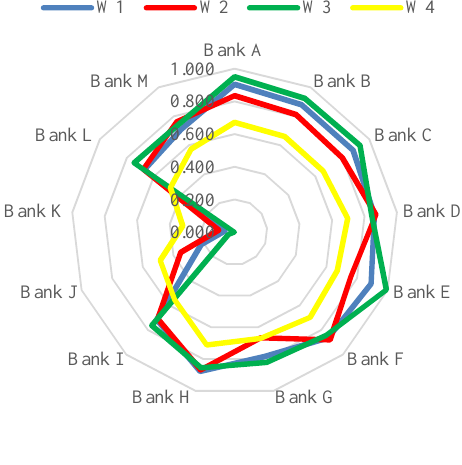
Figure 1. Resistance of commercial banks to potential COVID-19 pandemic impacts determined by the Hellwig method taking into account different weighting systems (Option